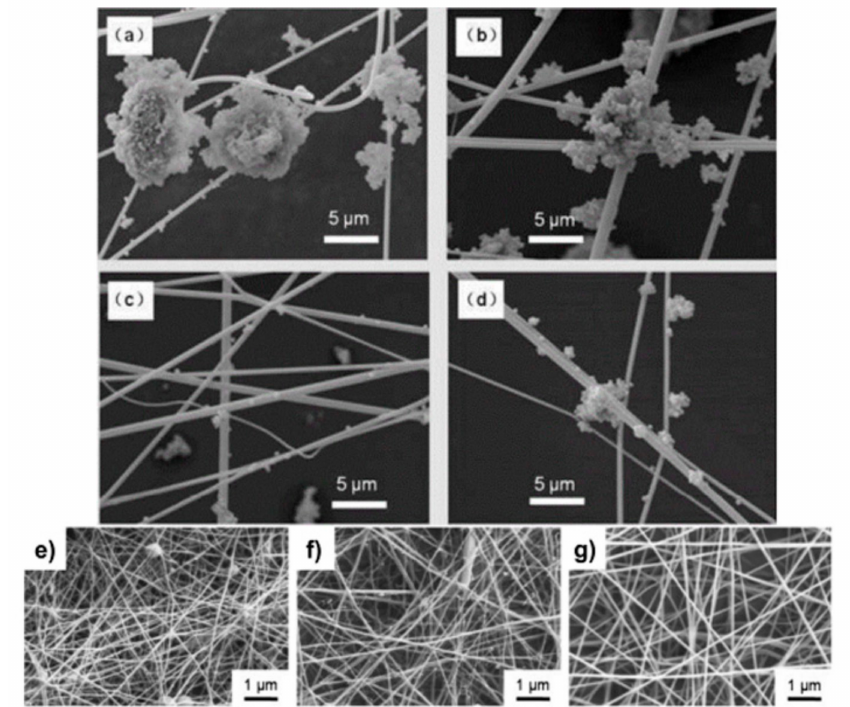
Figure4. SEMimagesofe-spun( a )chitosan, ( b )polyacrylonitrile(PAN),( c )polyvinylpyrrolidone(PVP), and ( d ) PS (Polystyrene) nanofibers in the polluted air. SEM images of 1.33 wt% HMW (high molecular weight) chitosan:PEO (polyethylene oxide) (90:10) fibers spun on spunbonded polypropylene (PP) using ( e ) 75% acetic acid (AA), ( f ) 90% AA, and ( g ) 75% AA (2 mM). Reproduced with permission from [104]. Copyright 2017 The Royal Society of